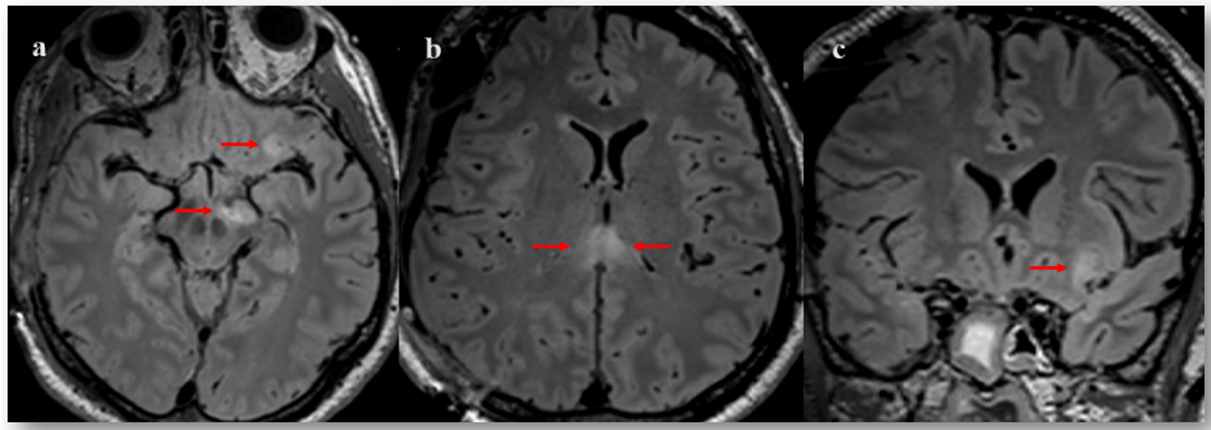
Figure 2. Figure 2. Fluid attenuated inversion recovery (FLAIR) magnetic resonance imaging taken 13 days post-severe TBI. Axial and coronal sections showing areas of hyperintense signal (indicated with arrows) in the left cerebral peduncle ( a ), orbito-frontal cortex ( a , c ) and splenium of corpus callosum ( b